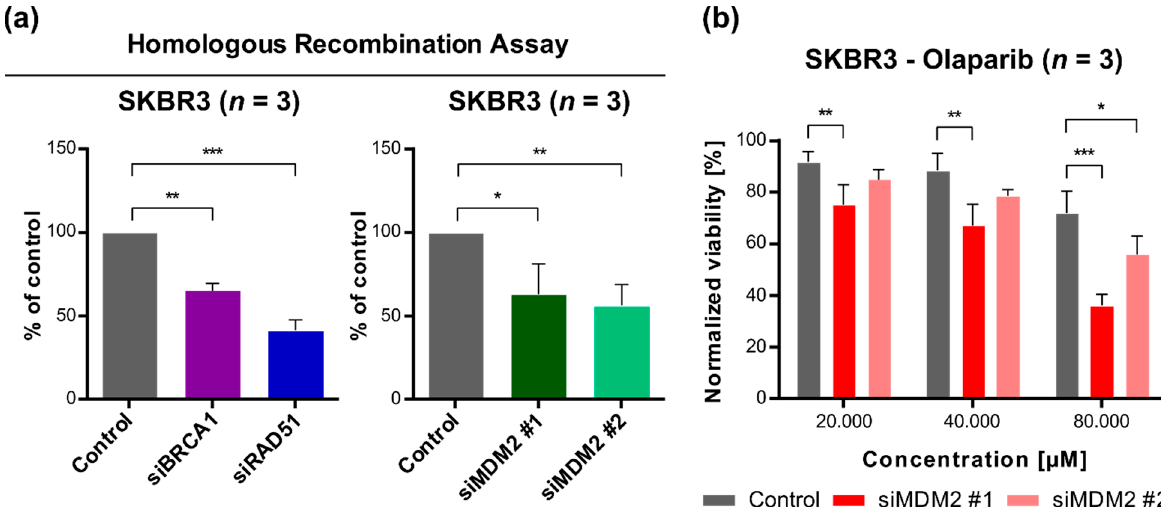
Figure 4. Analysis of homologous recombination DNA repair efficiency and sensitivity to olaparib in SKBR3 cells following MDM2 gene silencing. ( a ) Homologous recombination assay assessment of the homologous recombination efficiency after silencing the expression of two genes important for the studied DNA repair pathway and MDM2 gene (right panel). Statistical significance was assessed by comparing siRNA against the specific gene of interest with the control (non-specific siRNA). ( b ) Metabolic activity of SKBR3 cells (HER2-enriched subtype) treated for 72 h with olaparib (PARP inhibitor). The viability was normalized to untreated cells. Statistical significance was assessed by comparing two silencing sequences (siMDM2#1, siMDM2#1) with the control (non-specific siRNA) at each concentration of olaparib, * p < 0.05, ** p < 0.01, *** p < 0.001. n —the number of independent experiments performed.